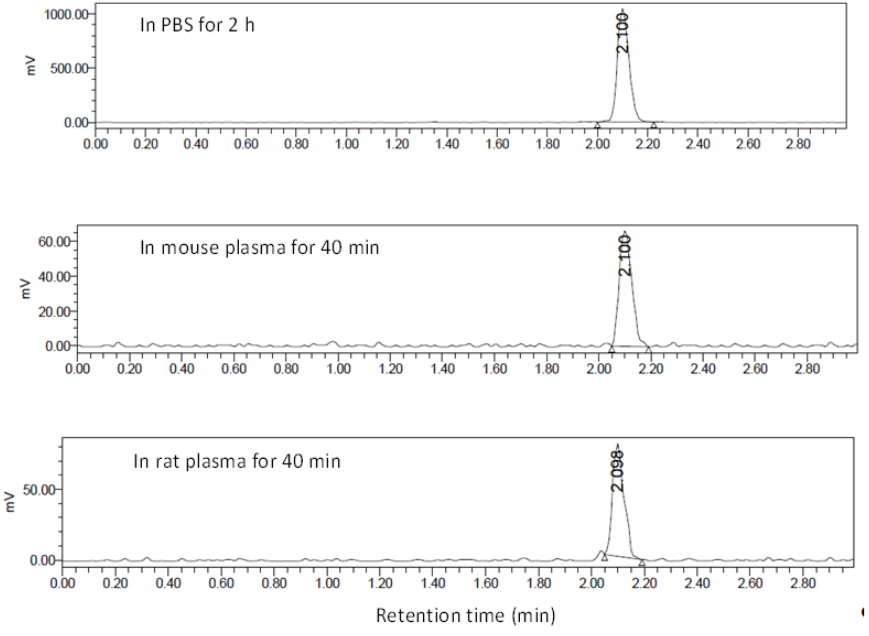
Figure 2. Radio-UPLC profiles of [ 11 C]KP23 (t 40 min in mouse and rat